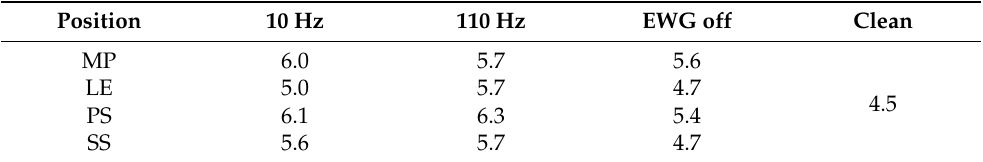
Table 3. Mass average total pressure loss coefficients.